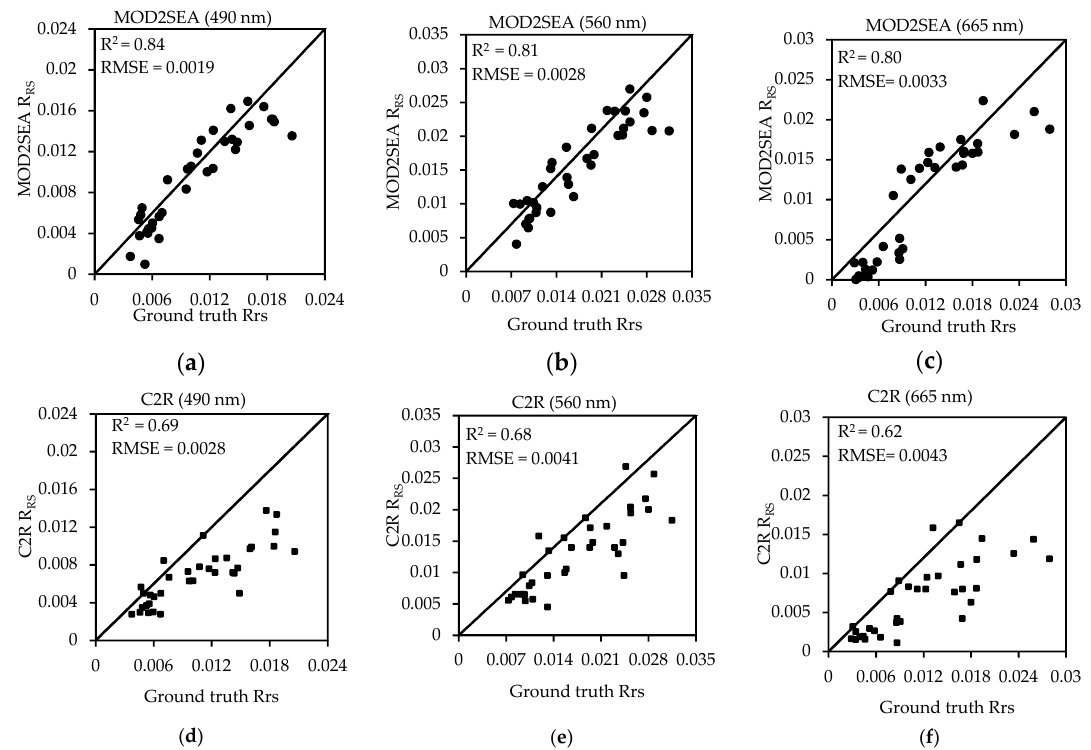
Figure 6. Comparison between MERIS-retrieved values and ground truth measurements for water-leaving re fl ectance values (Rrs) for 35 matchup in 2007 − 2010 at NIOZ jetty location. ( a – c ) represent the retrieved Rrs using the coupled MOD2SEA model against ground truth measurements for MERIS band of 3, 5 and 7 (band centers: 490, 560 and 665 nm) respectively; ( d – f ) represent the retrieved Rrs values using C2R processor against ground truth measurements for MERIS bands centers of 3, 5 and 7 (band centers: 490, 560 and 665 nm) respectively.